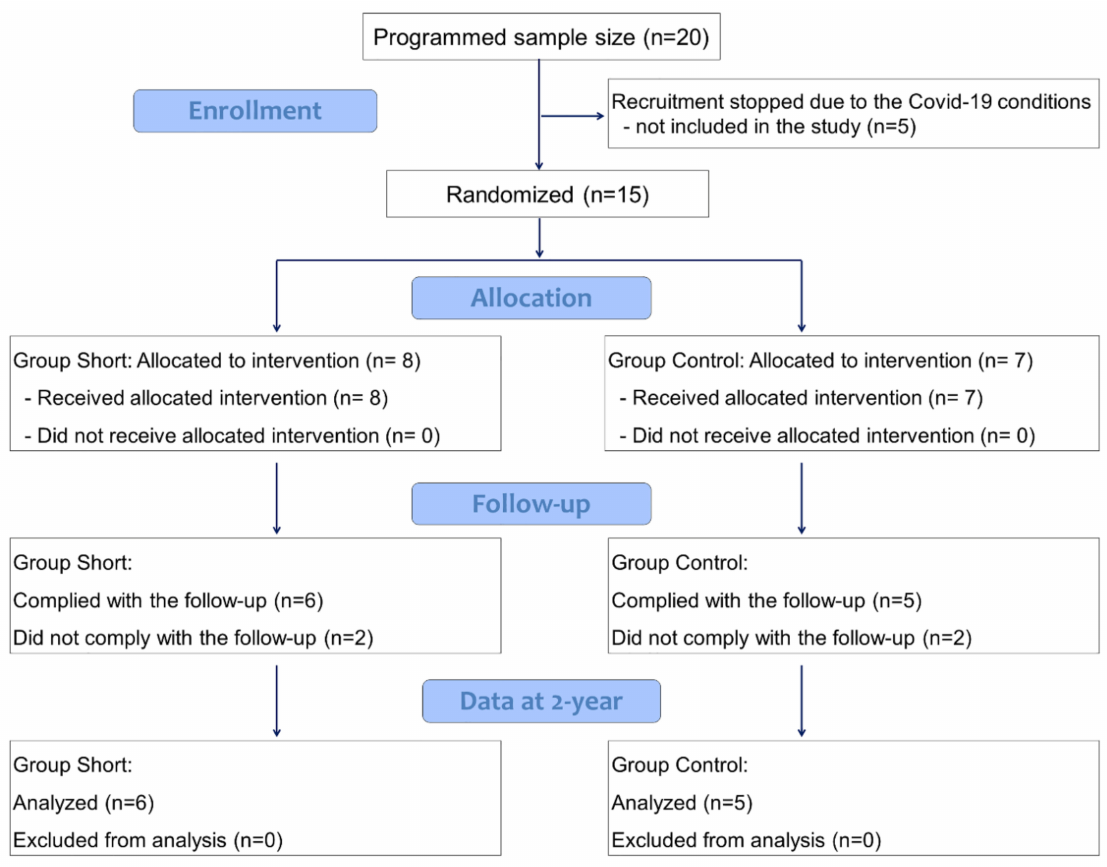
Figure 3. CONSORT 2010 flow